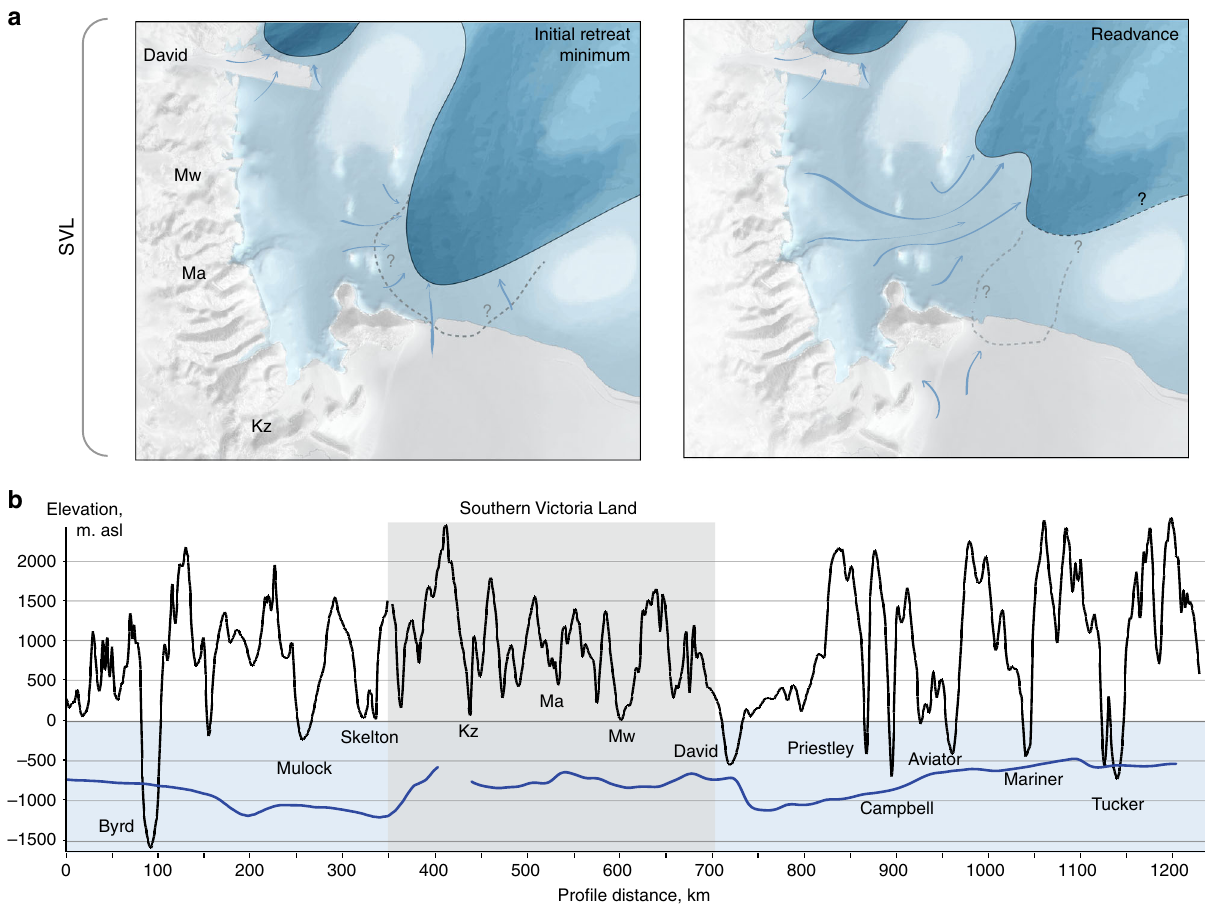
Fig. 7 Readvance con fi guration and relationship to the relief of contributing glacier outlets. a Initial retreat of ice through JOIDES Trough creates embayment in Central Basin, allowing SVL and southern TAM subsectors to unzip and behave independently. SVL outlets drive a readvance into southern JOIDES Trough. The magnitude of retreat prior to readvance is uncertain, as is the grounding line / ice shelf extent over Central Basin during readvance (dashed lines). Background bathymetry from IBCSO 76 . b Topographic and bathymetric pro fi les of the TAM/Ross Sea coast (from IBCSO 76 ); TAM pro fi le (black) follows coast approximately 50% to watershed; Ross Sea pro fi le (blue) follows coastal trough axis). Outlet glaciers of SVL are considerably less incised than either the northern or southern TAM and therefore ice entering the Ross Sea coastal trough from SVL is thinner. This sector will therefore be more vulnerable to drawdown, acceleration (readvance) and grounding line instability (subsequent retreat), until the grounding line retreats to and stabilises at the coastal zone. Kz = Koettlitz Glacier, Ma = Mackay Glacier, Mw = Mawson